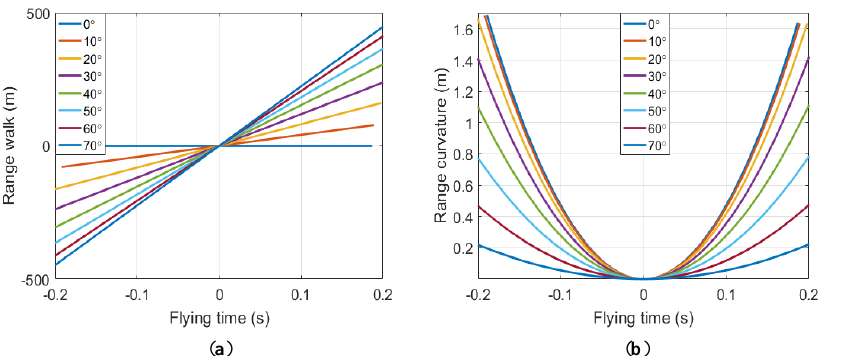
Figure 5. The spatial variations of first- and second-order RCM with v = 2380 m/s and different squint angles. ( a ) Range walk versus flying time. ( b ) Range curvature versus flying time.